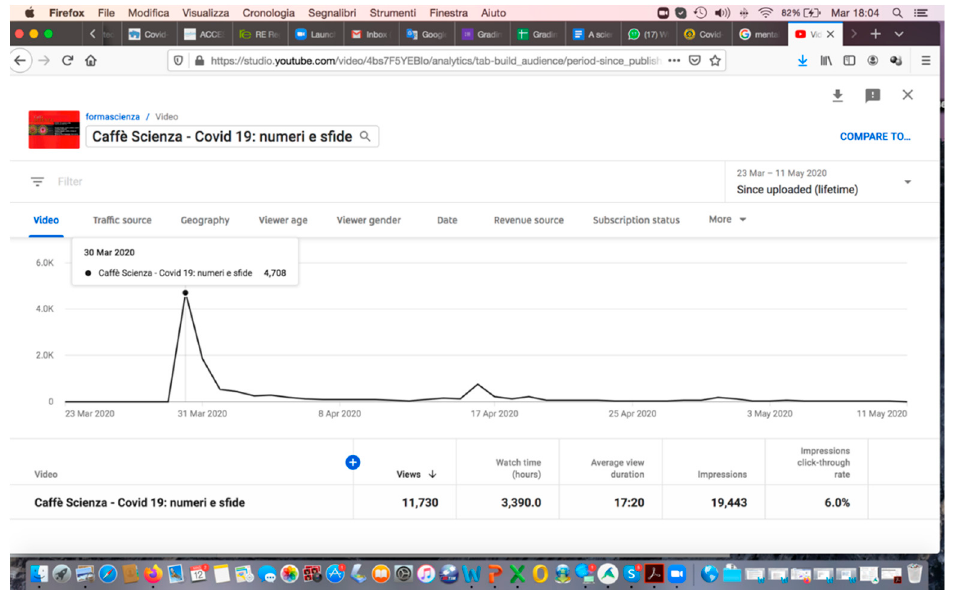
Figure 2. YouTube analytics for the number of views for the first Rome online science café. The 4.5 k peak on 31st March includes the more that 1000 synchronous views and the about 3.0 k views immediately after the conclusion.